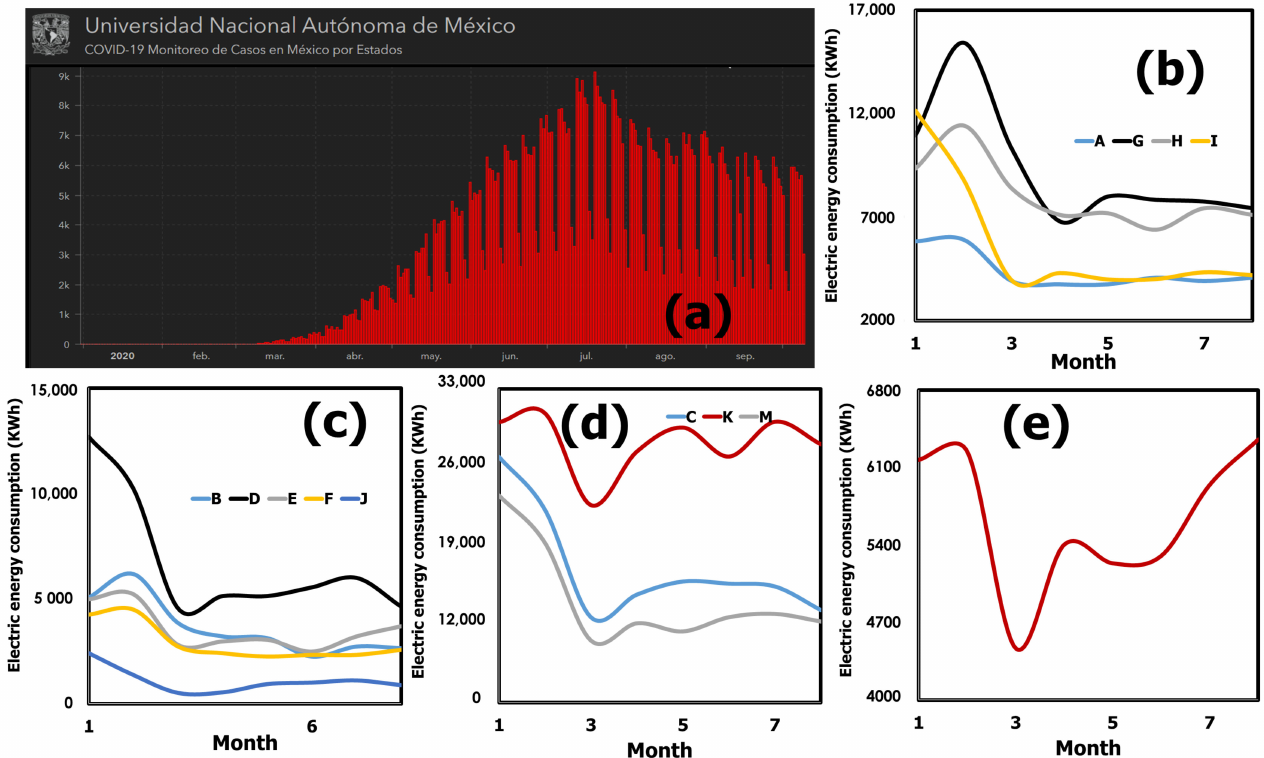
Figure 4. ( a ) Distribution of contagions until the first peak of 2020. Variation in energy consumption in the first months of confinement in Mexico (March = 1): ( b ) Universities in rural and indigenous areas ( c ) Universities in suburban and peri-urban areas ( d ) Universities in urban areas ( e ) Virtual